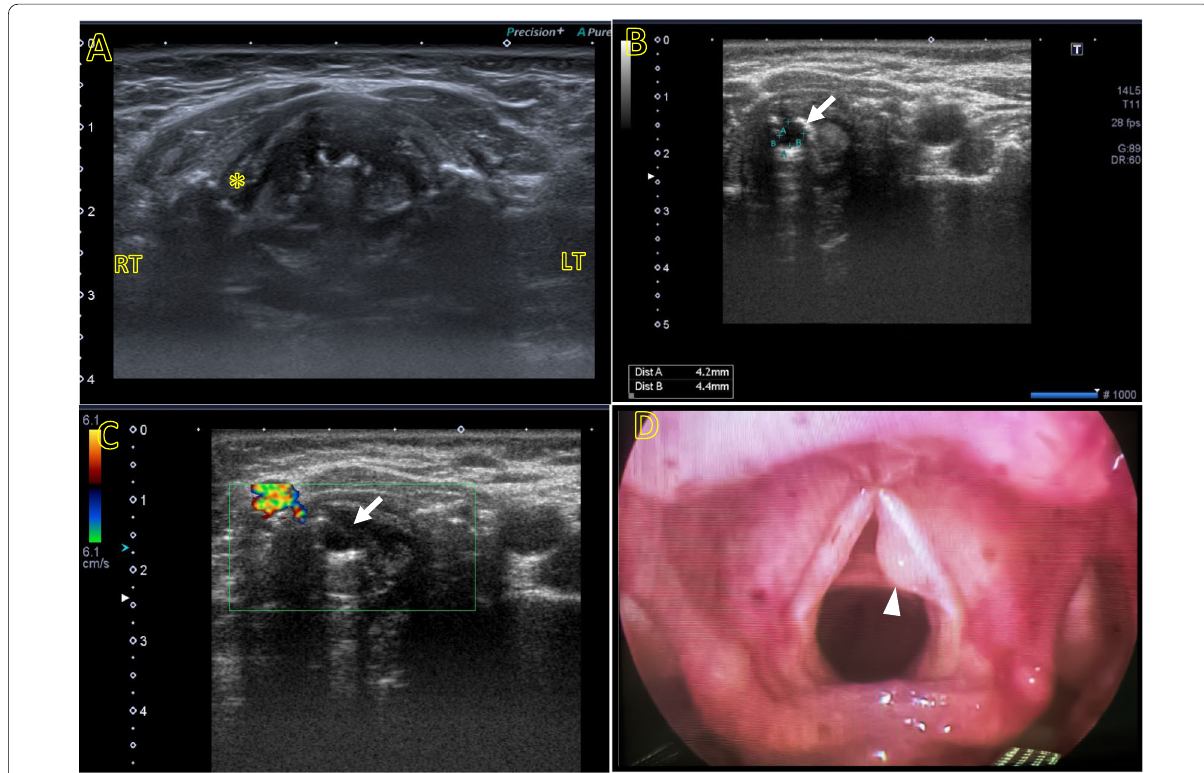
Fig. 2 A 55-year-old female patient presented with hoarseness of voice and GERD. A Laryngeal ultrasound anterior axial view showing the anatomical landmarks along the level of the true vocal cord with thyroid cartilage seen (asterisk) and right/left landmarks on the image. B Left lateral axial view shows left VC anechoic lesion measures about 4 mm (arrow) with no color Doppler signal uptake could be traced C denoting vocal cord cyst. D Flexible laryngoscopy of the same patient shows a left VC cyst (arrow head), matching the sonographic diagnosis